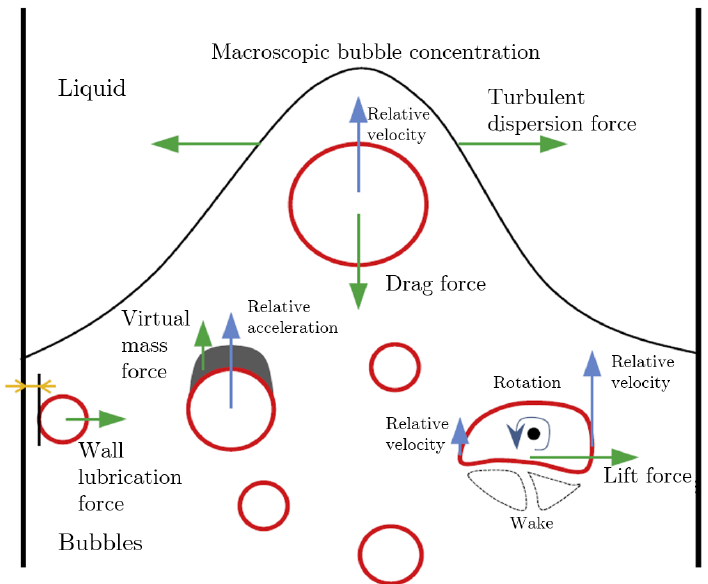
Figure 5. Schematic representation of the interphase forces acting on a bubble. Reprinted with permission from